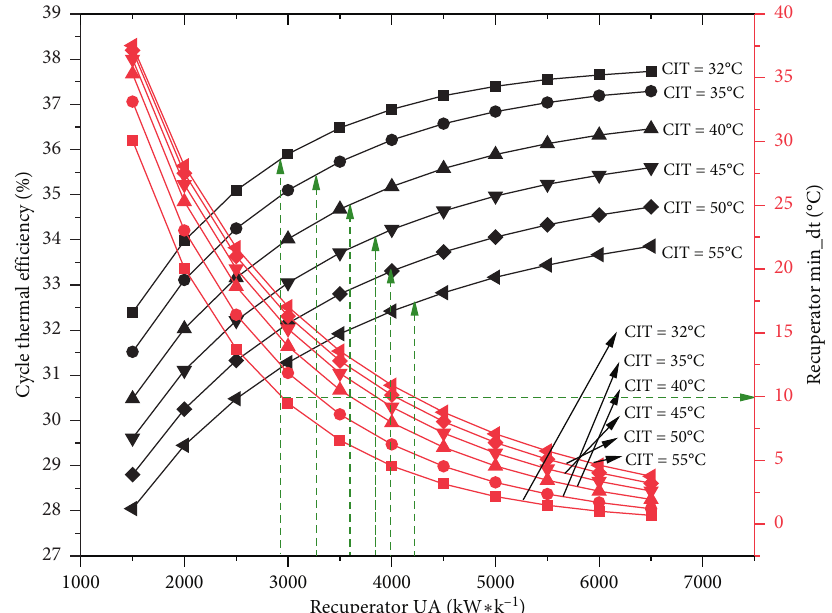
Figure 11: Effects of the recuperator UA on the cycle thermal efficiency for dry-cooled